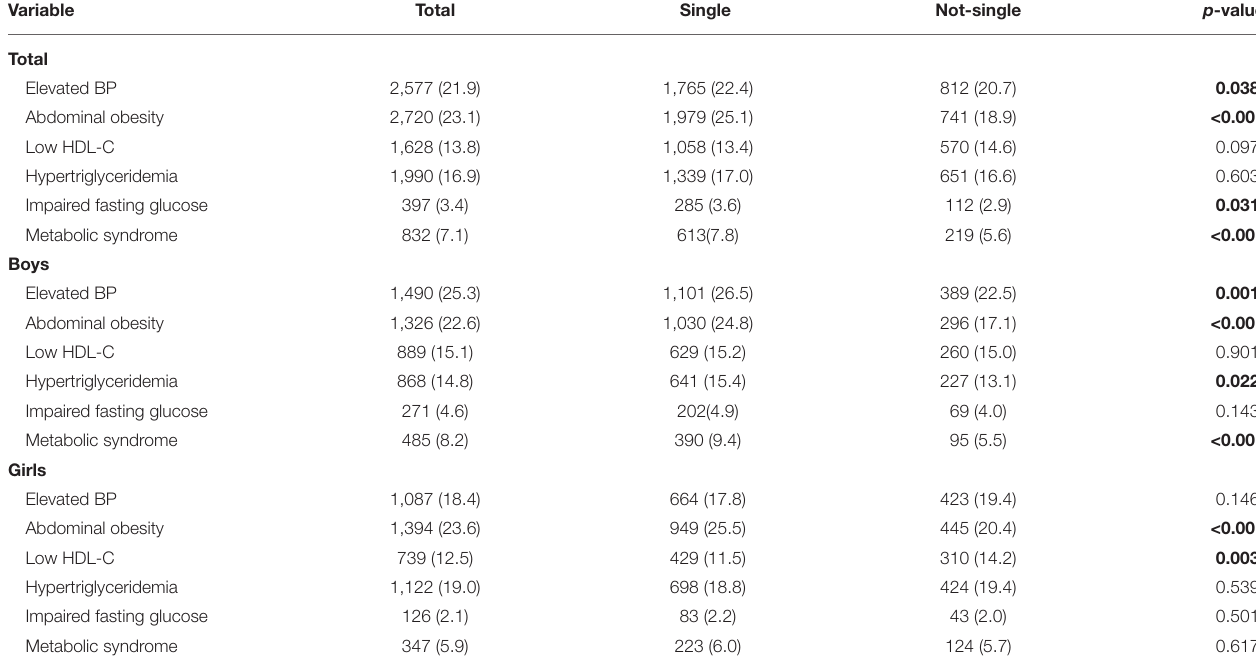
TABLE 2 | A comparison of the prevalence of CVD risk factors between single children and not-single children, stratified by sex. Variable Single